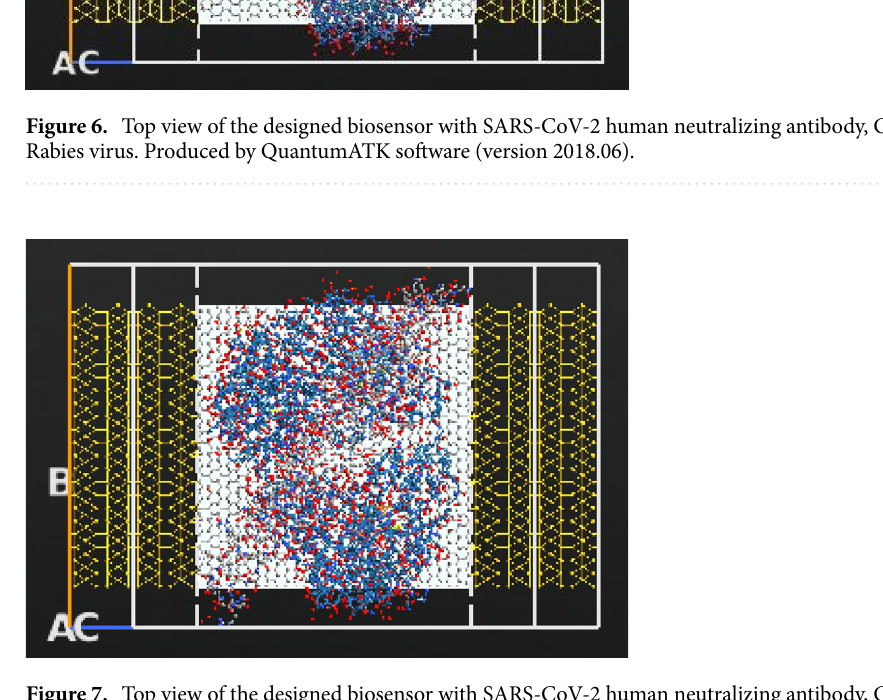
Figure 7. Top view of the designed biosensor with SARS-CoV-2 human neutralizing antibody, Cu MNPs and MERS virus. Produced by QuantumATK software (version